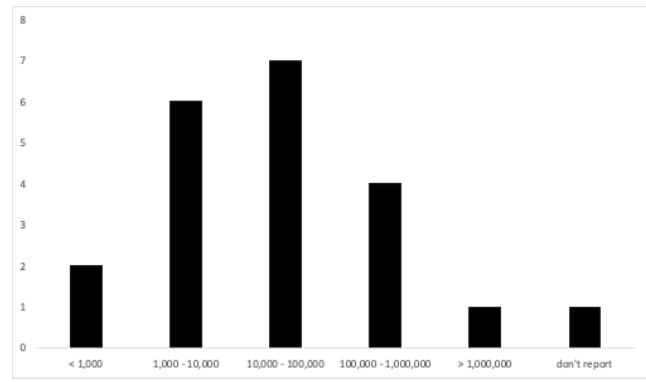
Figure 4. Number of published articles by sample